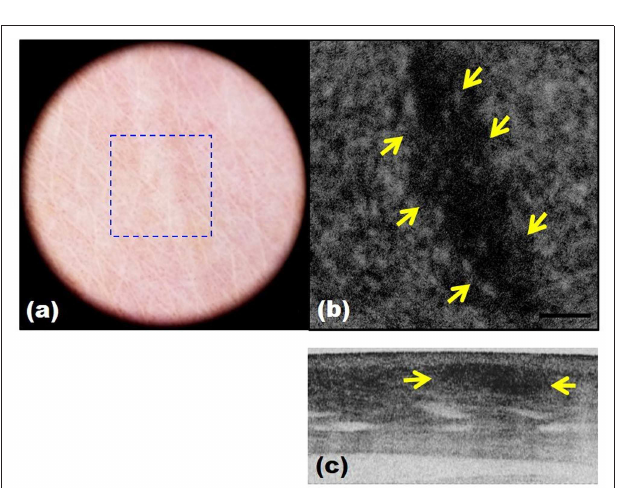
FIGURE 7 | Ultrasound image of malignant proliferating trichilemmal tumor.